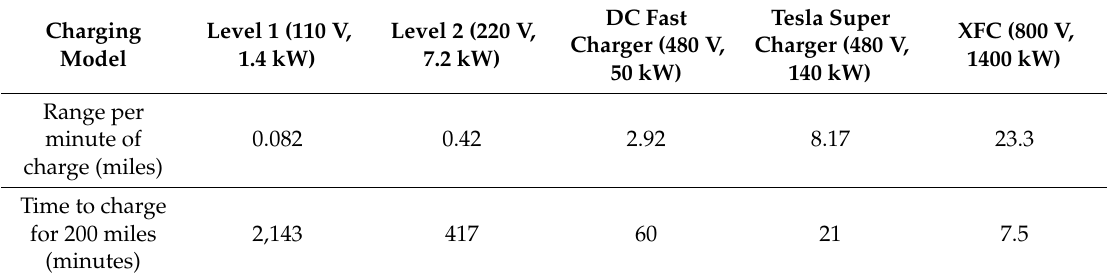
Table 3. Source: McCarthy, Michael. “California ZEV Policy Update.” SAE 2017 Government / Industry Meeting, Society of Automotive Engineers, 25 January 2017, Walter E. Washington Convention Center, Washington, DC. Conference Presentation. [XFC—Extra Fast Charging Li-Ion Battery Market Review